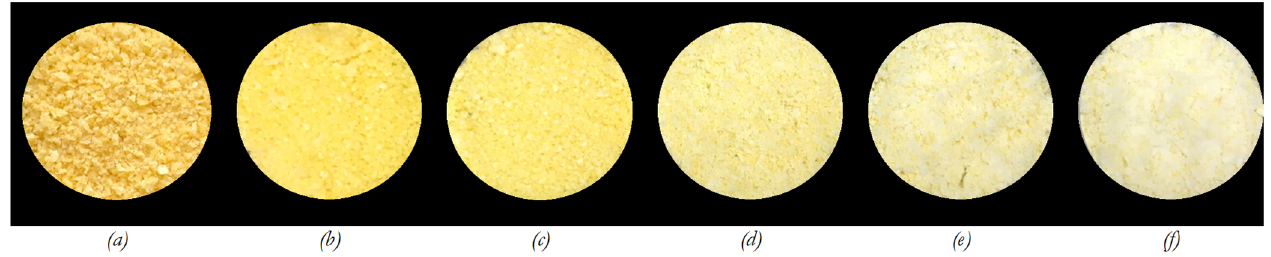
Figure 2 . Different breadcrumb:EVOO α CD mixes: ( a ) breadcrumb without EVOO: α CD addition; ( b ) 3:1 weight w : w , ( c ) 2:1 w:w , ( d ) 1:1 w:w , ( e ) 1:2 w:w ; and ( f ) 1:3 w:w